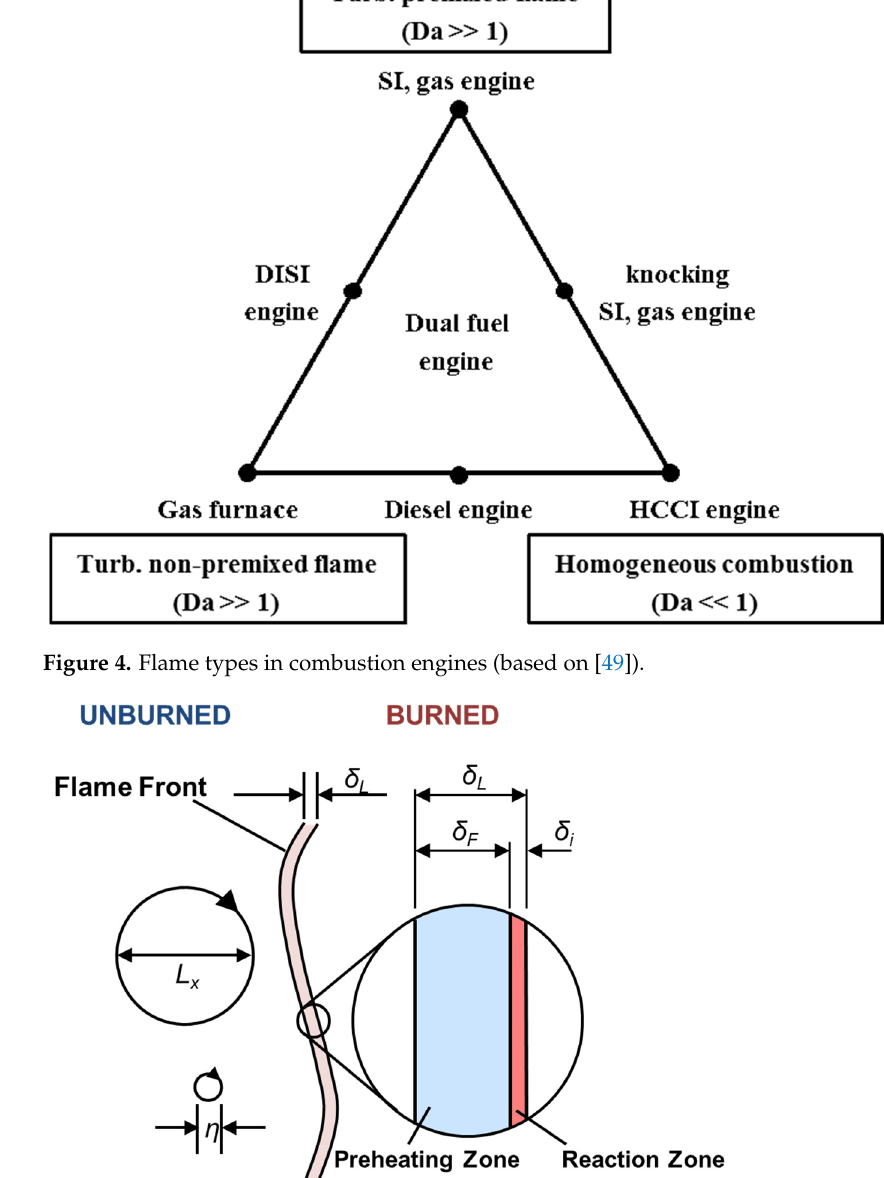
Figure 4. Flame types in combustion engines (based on [49]).